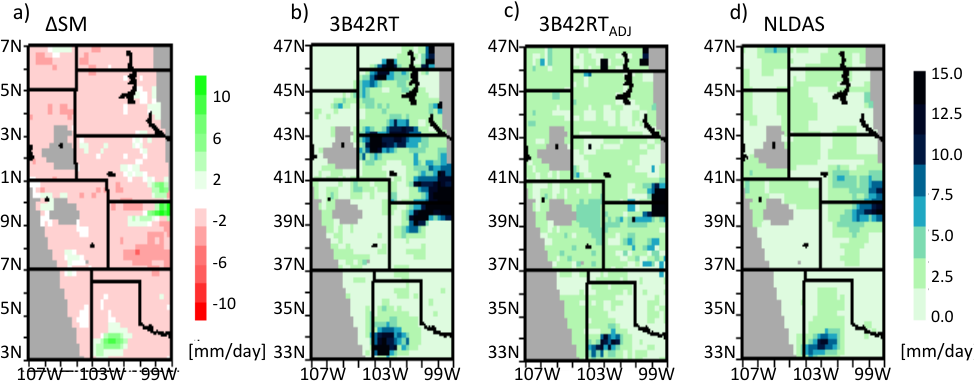
Figure 8. 26 May 2006 rainfall pattern in 3B42RT (b) against NLDAS (d) as detected by AMSR-E/LSMEM (cid:49) SM (a) , and recovered rainfall field (3B42RT ADJ ) by assimilating AMSR-E/LSMEM (cid:49) SM (c) . Gray shading shows area without soil moisture retrievals.